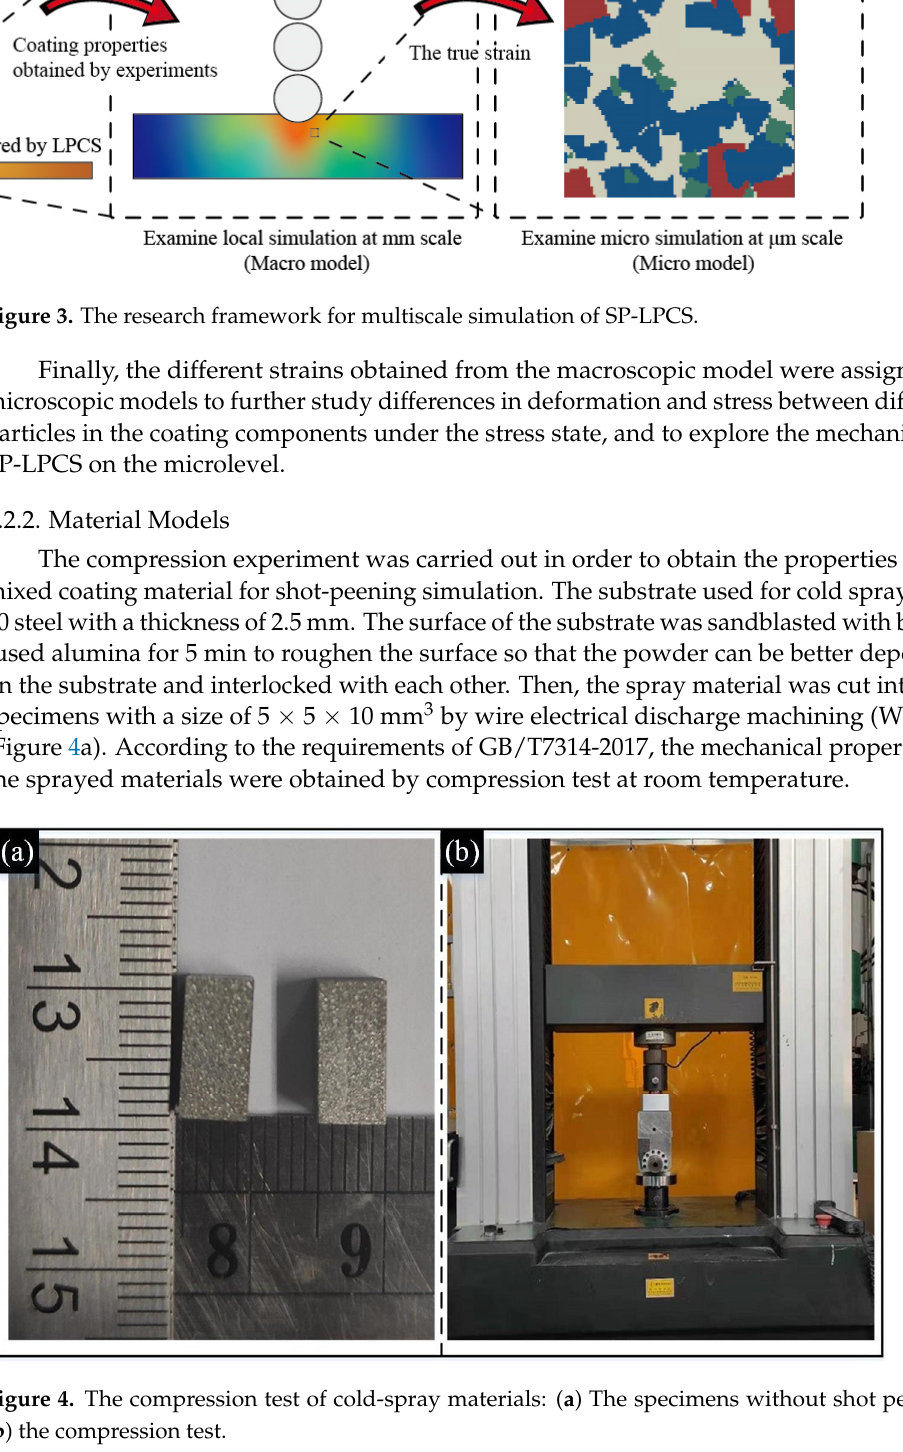
Figure 5. The compressive stress–strain curve of sprayed material without shot peening. Table 3. The mechanical property parameters of Al-Zn coating. Elastic Modulus/MPa